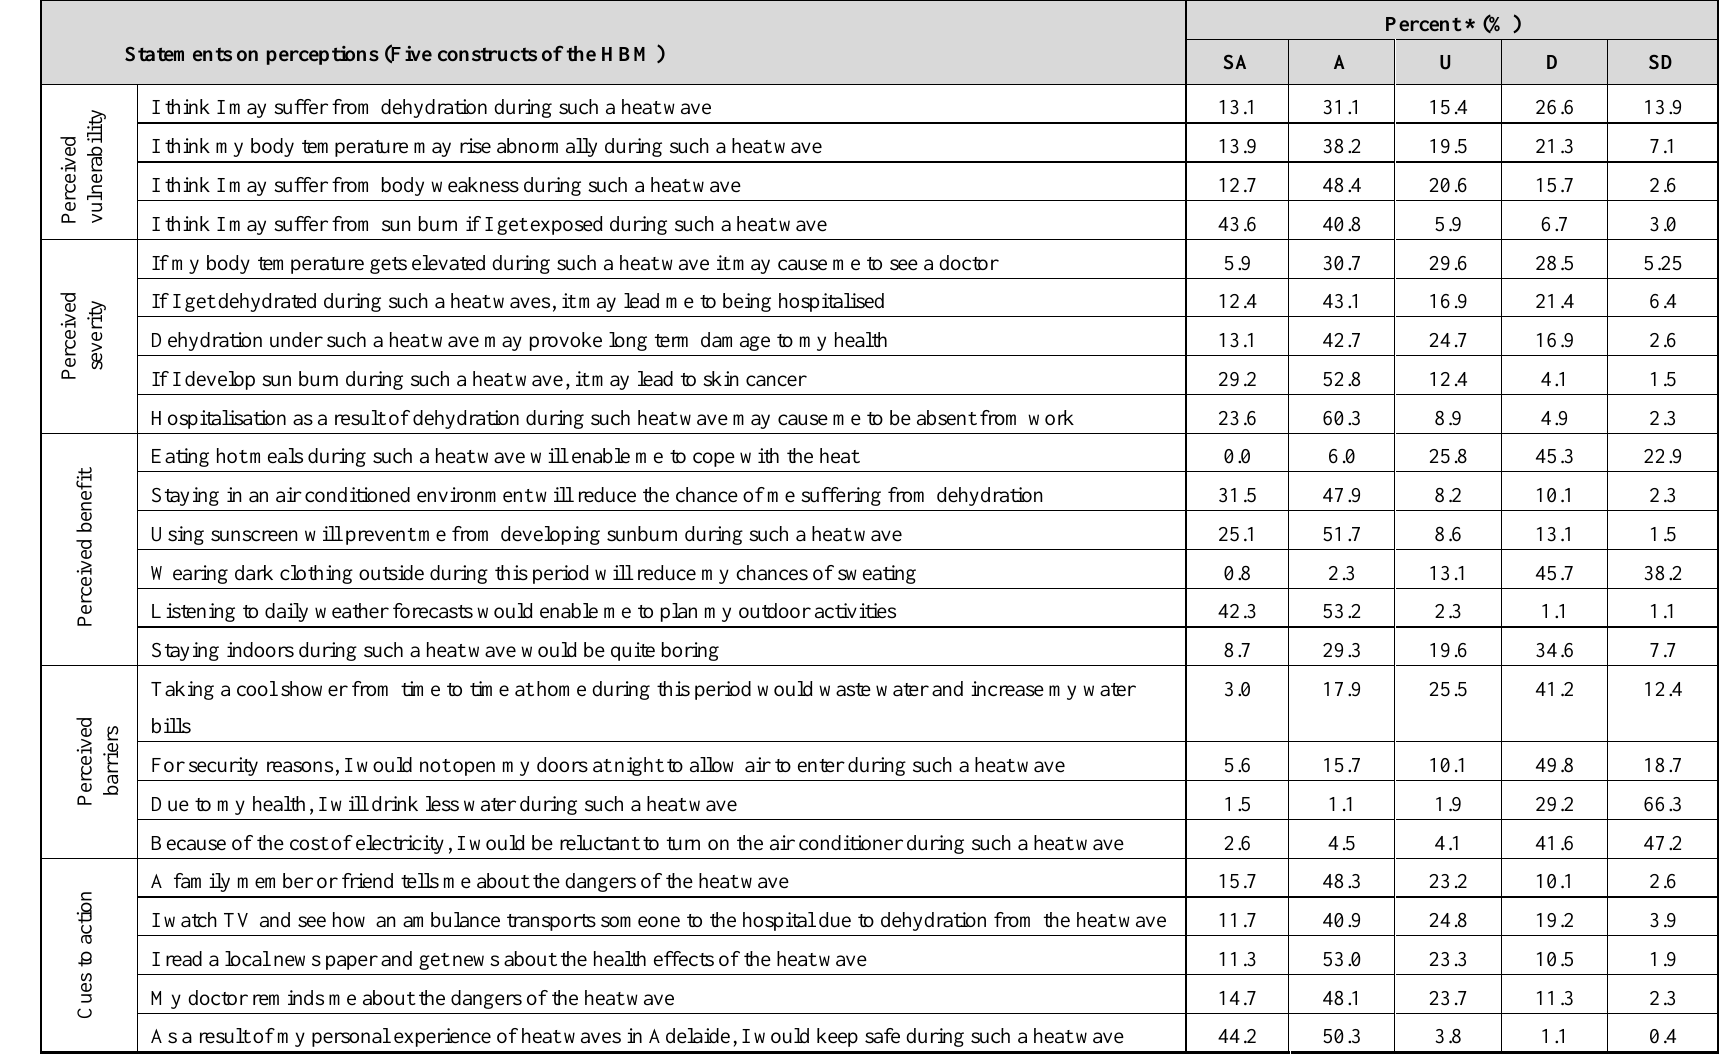
Table 5. Participants’ responses to statements on perceptions in the context of a heat wave scenario using constructs of the health belief model. Statements on perceptions (Five constructs of the